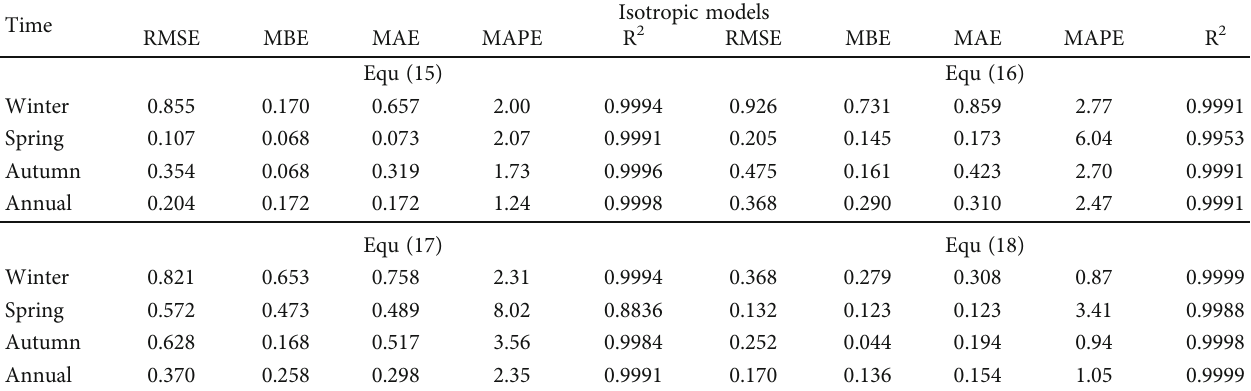
Table 6: Statistical errors of the developed equation using isotropic and anisotropic.